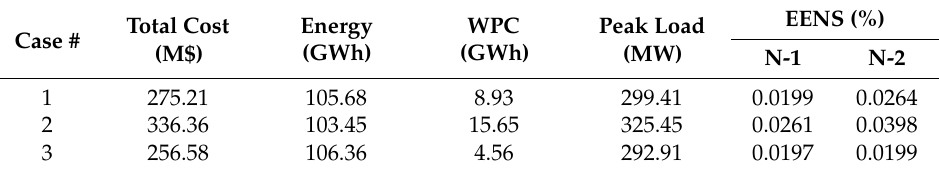
Table 3. Result comparison for cases 1–3 with 100 MW wind power.